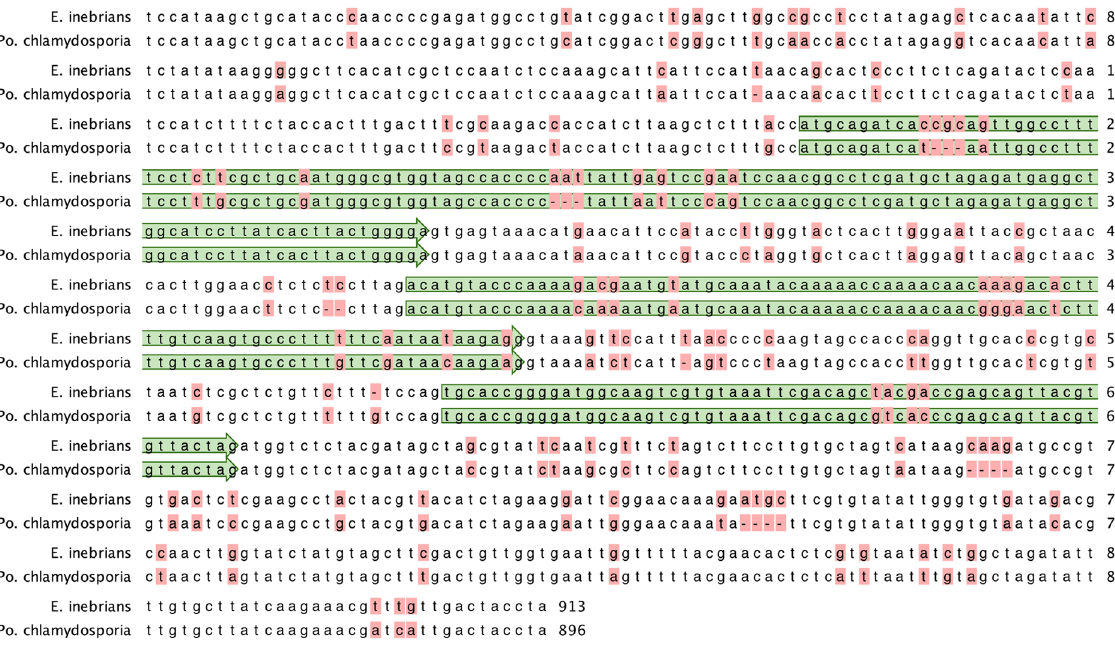
Figure 10. Similarity of the E . inebrians and Po . chlamydosporia antifungal protein DNA sequences extends through the upstream and downstream regions of the gene. The antifungal protein coding sequences are boxed in green. Differences between the two sequences are boxed in red.